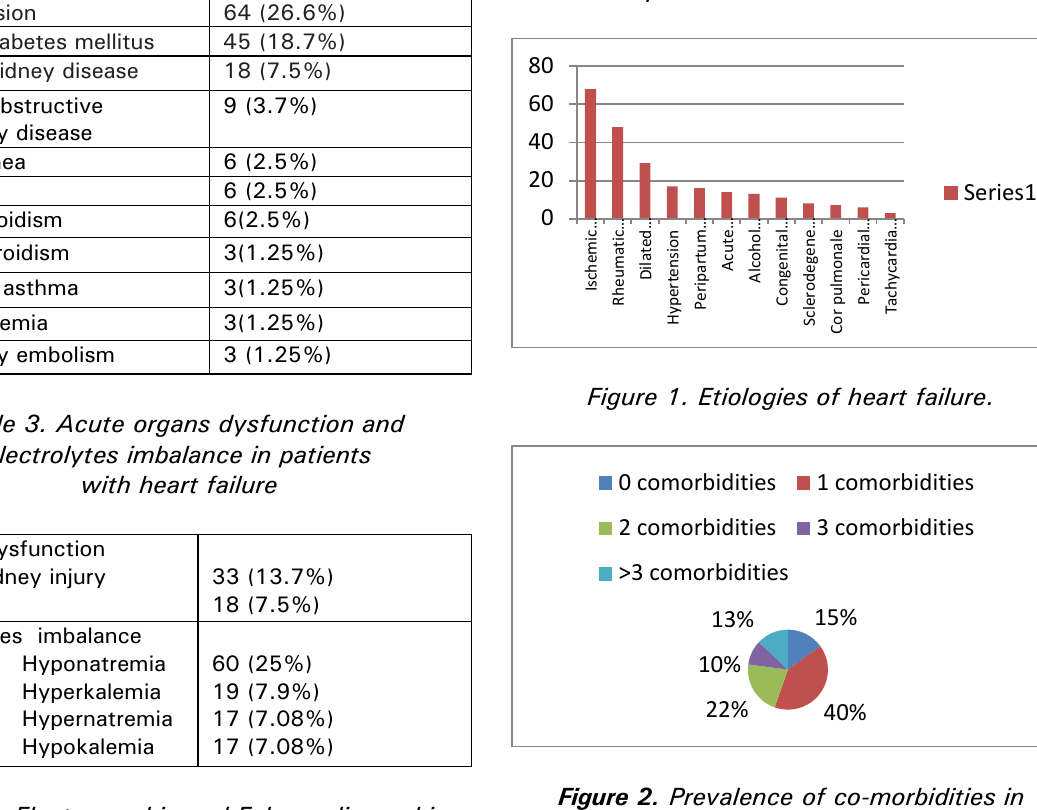
Table 4. Electrographic and Echocardiographic co-morbidities in patients with heart failure Electrocardiogrphic